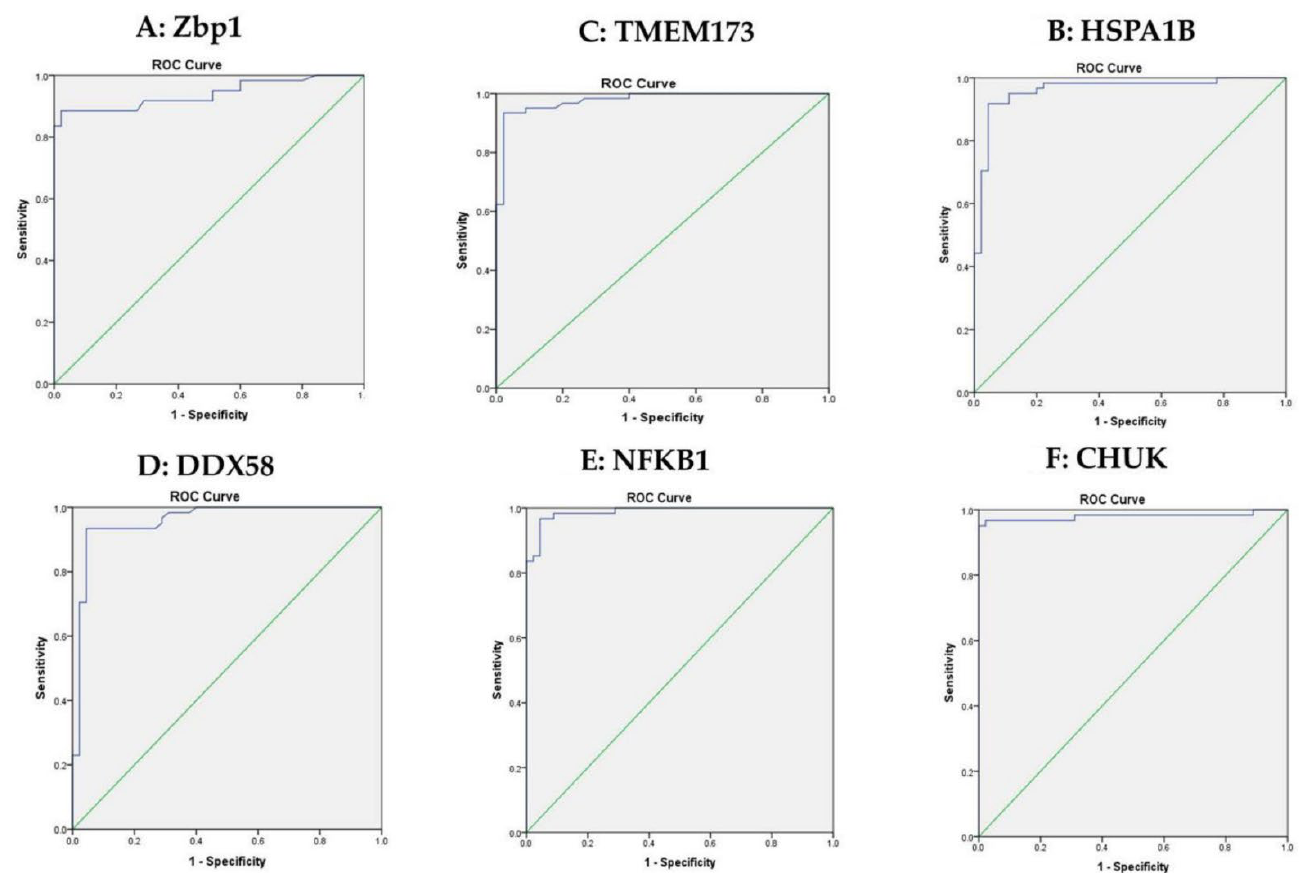
Figure 2. ROC curve analysis for the 6 mRNAs to discriminate between healthy controls and T2DM. ( A ): ROC curve analysis for serum Zbp1 used to calculate the best cutoff point to discriminate between T2DM and healthy controls. The best cutoff point for Zbp1 was ≥ 3.25 (sensitivity = 88.5%, specificity = 97.8%). ( B ): ROC curve analysis for serum HSPA1B used to calculate the best cutoff point to discriminate between the T2DM and healthy controls. The best cutoff point for HSPA1B was ≥ 4.7817 (sensitivity = 91.8%, specificity = 95.6%). ( C ): ROC curve analysis for serum TMEM173 used to calculate the best cutoff point to discriminate between the T2DM and healthy controls. The best cutoff point for TMEM173 was ≥ 4.005 (sensitivity = 93.4%, specificity = 97.8%). ( D ): ROC curve analysis for serum DDX58 used to calculate the best cutoff point to discriminate between the T2DM and healthy controls. The best cutoff point for DDX58 was ≥ 7.750 (sensitivity = 93.4%, specificity =95.6%). ( E ): ROC curve analysis for serum NFKB1 used to calculate the best cutoff point to discriminate between the T2DM and healthy controls. The best cutoff point for NFKB1 was ≥ 6.525 (sensitivity = 96.7%, specificity = 95.6%) ( F ): ROC curve analysis for serum CHUK used to calculate the best cutoff point to discriminate between the T2DM and healthy controls. The best cutoff point for CHUK was ≥ 3.640 (sensitivity = 96.7%, specificity = 97.8%). Green line represents diagonal random classifier.